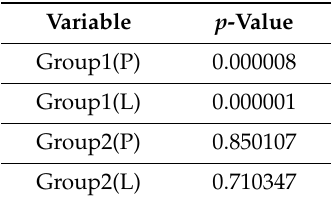
Table 7. Results of sign tests.